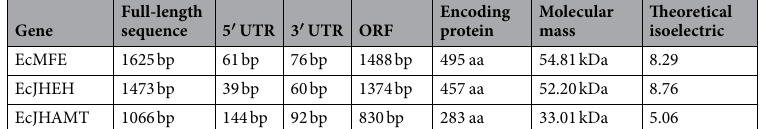
Table 1. Information of cDNA and amino acid